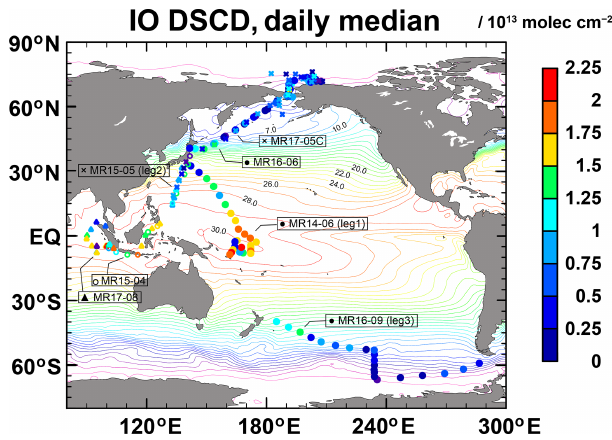
Figure 4. Daily median IO content (DSCDs for an elevation angle of 3 ◦ ; molec.cm − 2 ) observed from the R/V Mirai during 2014– 2018. Color contours represent the optimum interpolated SST aver- aged for